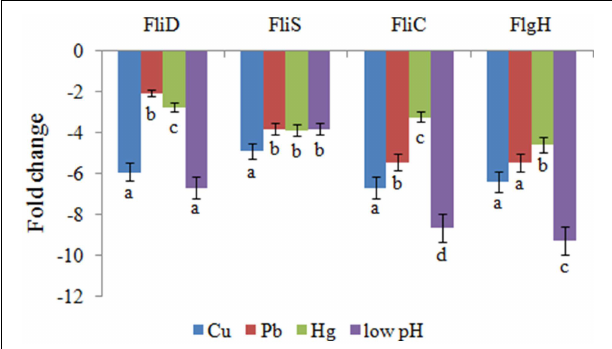
FIGURE 1 | QPCR analysis of the expression of FliD , FliC , FlgH , and FliS after stress treatments in comparison to untreated control. The data are presented as the means ± S.D. ( n = 6 ).The means of the treatments not sharing a common letter are significantly different at P < 0 . 05 .